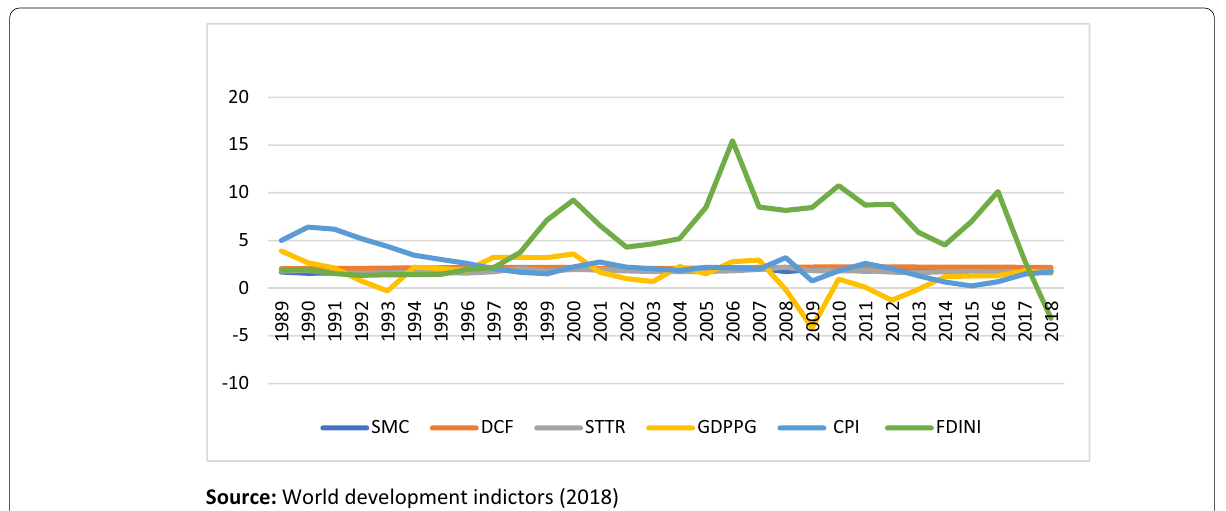
Fig. 1 Average growth of variables in Western Europe 1989–2018. Source : World development indictors